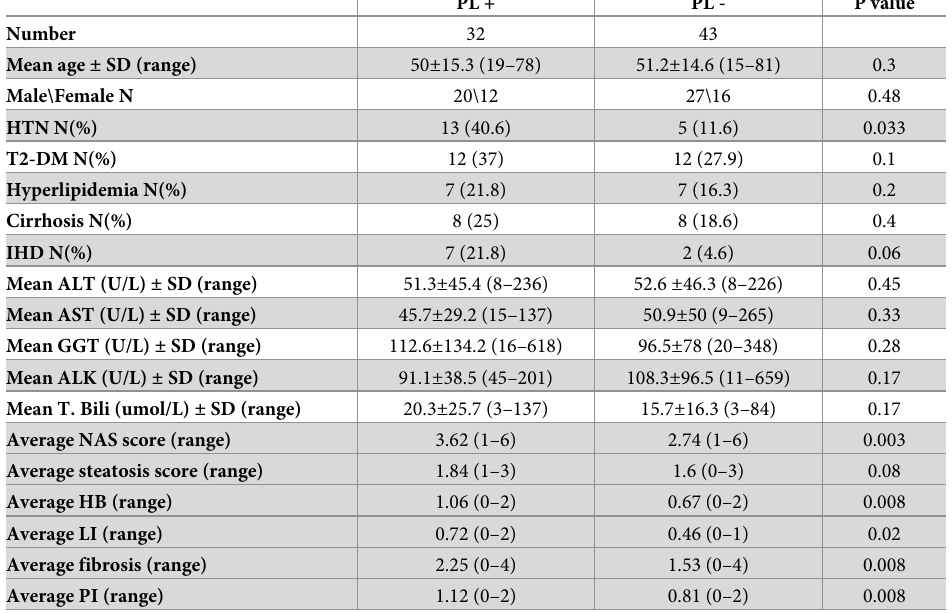
Table 2. Baseline characteristics of PL+ and PL-